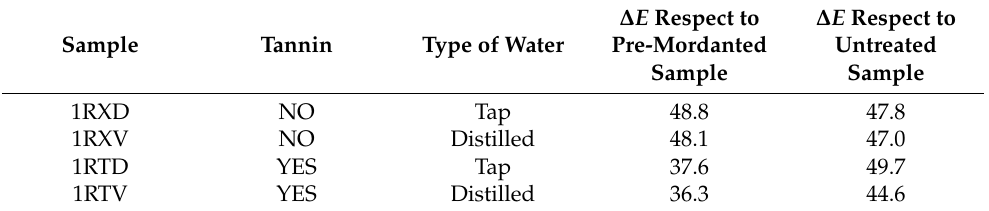
Table 5. Colorimetric values obtained of the pre-mordanted samples dyed with common madder.